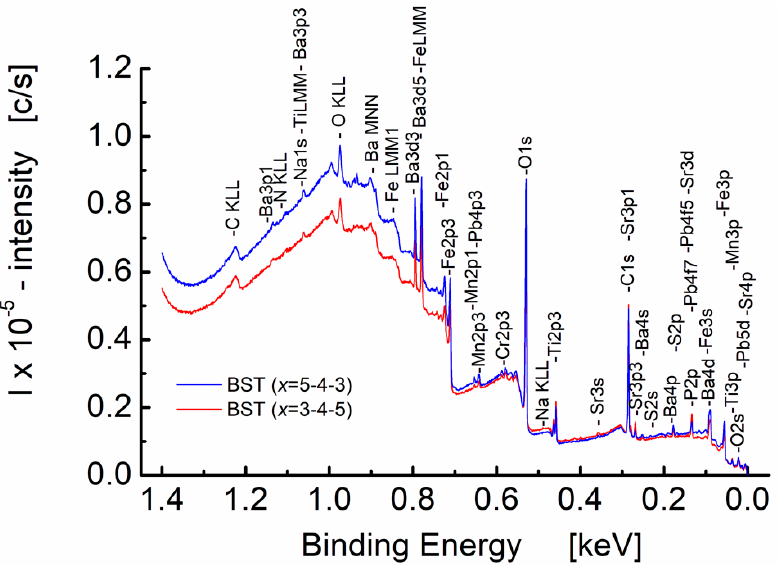
Figure 7. X-ray photoelectron survey spectra recorded from the surface of BST thin films deposited on the stainless-steel substrate and fired at T = 700 ° C. BST ( x = 5-4-3)—blue line, and BST ( x = 3-4-5)—red line.